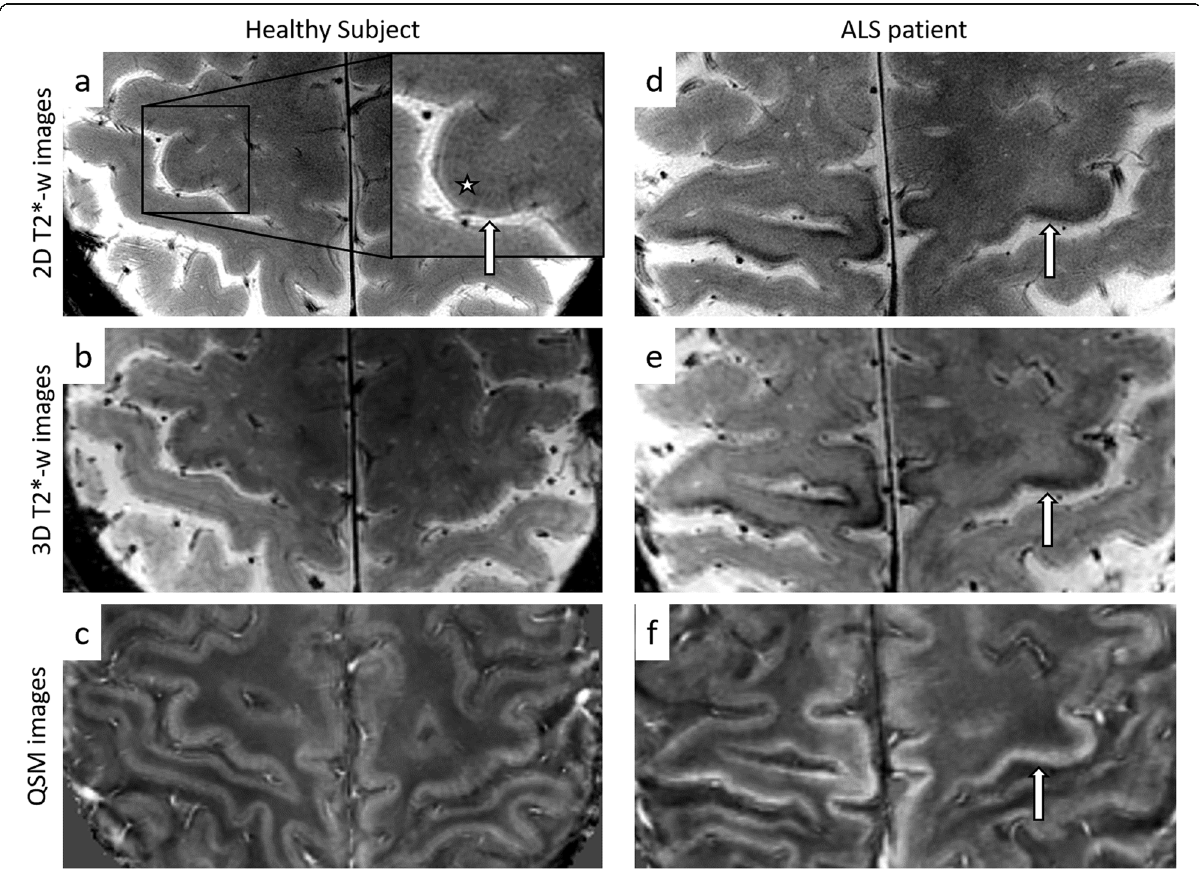
Fig. 4 T2*-weighted images and QSM images of the primary motor cortex in a healthy subject ( a – c ) and an ALS patient ( d – f ). a In healthy subjects, two strips are recognisable in the primary motor cortex: a thin superficial hyperintense strip (arrow) and a thicker and slightly hypointense deep band (*). In many ALS patients, the deep strip is abnormally hypointense in T2*-weighted images (arrows in d and e ), and the hypointensity corresponds to higher values of magnetic susceptibility (arrow in f